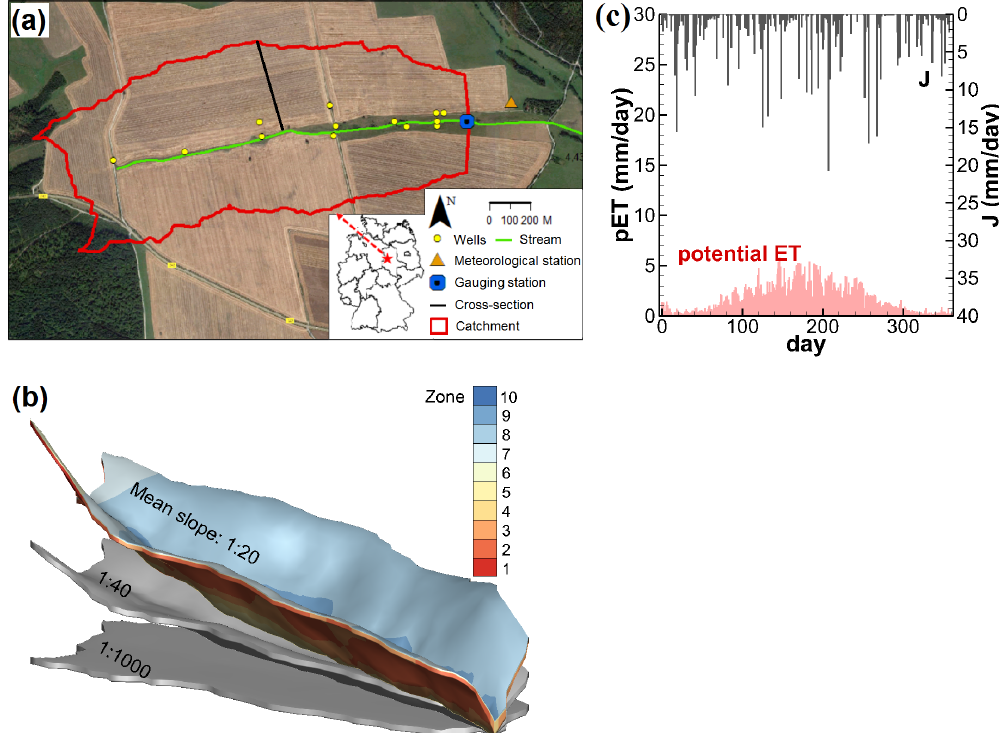
Figure 1. (a) The catchment “Schäfertal”, Central Germany (background image from © Google Maps). (b) The catchments with mean topographic slopes of 1 : 20, 1 : 40, and 1 : 1000. (c) The measured precipitation J and the estimated potential evapotranspiration ET for the year 2005 under the humid climate (Yang et al., 2018). Ten aquifer property zones in (b) were defined in the subsurface of the catchment for zonal parameter values (e.g., hydraulic